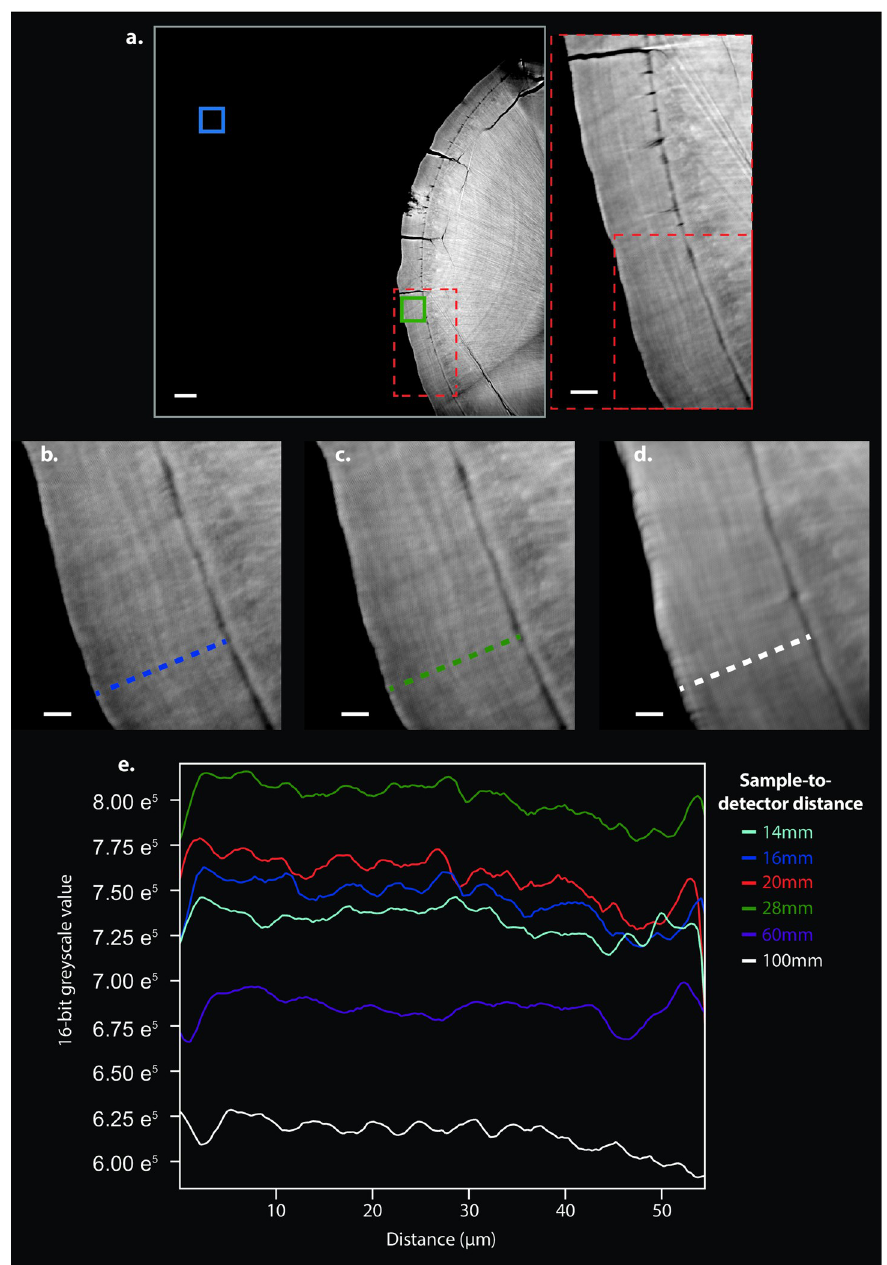
Fig 3. SR CT scan of a tooth root and regions for signal-to-noise ratio (SNR) and contrast-to-noise ratio (CNR) calculations. ( a ) One CT slice of the tooth root of Macaca mulatta individual l56. Blue box highlights the ROI for evaluation of background signal from which the mean greyscale value ( g ) and standard deviation of greyscale values b ( σ b ) was generated for SNR and CNR calculations (see Eqs (1) and (2)). The green box highlights the sampling area for ) was generated for SNR and CNR calculations. Dashed red cementum signal from which the mean greyscale value ( g c boxes indicate regions highlighted of the detail views. ( b ) Detail from region indicated by dashed red boxes in ( a ) from the dataset acquired at 16 mm sample-to-detector distance. ( c ) Detail from the same region from the dataset acquired at 28 mm sample-to-detector distance. ( d ) Detail from the same region from the dataset acquired at 100 mm sample- to-detector distance. ( e ) Plots of greyscale values along transects indicated by dashed lines in ( b-d ), acquired at different sample-to-detector distances. ( a-d ) White scale bars in ( a ) represent 100 μ m in the overview image, 30 μ m in the detail view highlighted by the red dashed box, and 10 μ m in ( b-d ).